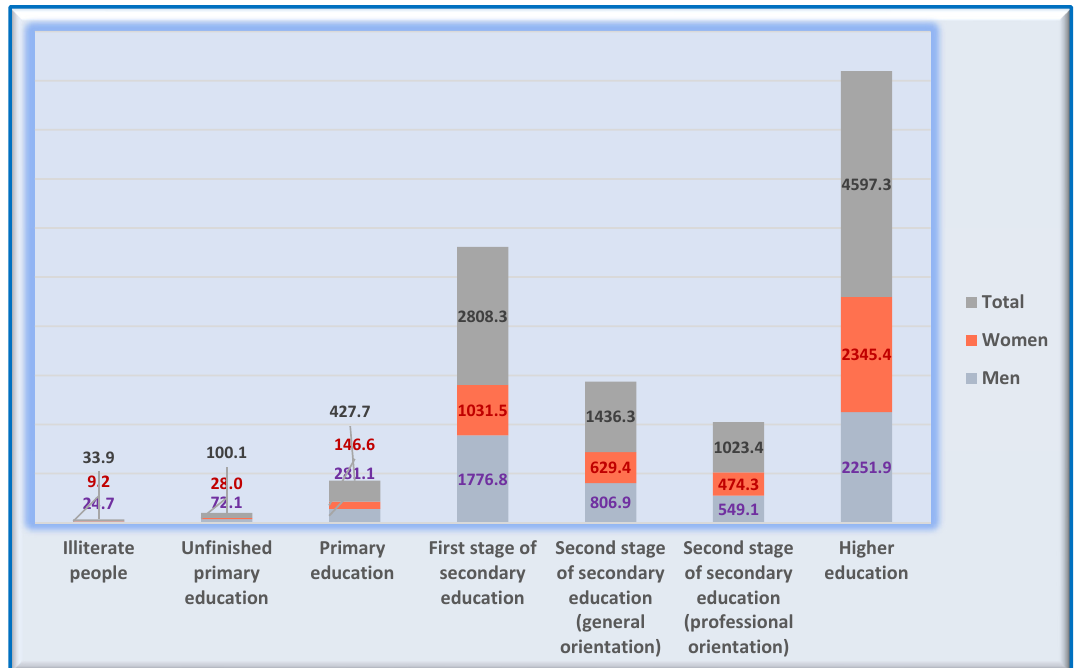
Figure 8. Employed married persons by sex and educational level attained (in thousands). Source: Authors with data corresponding to the fourth quarter of 2020 provided by the Statistics National Institute ( Instituto Nacional de Estadística ).